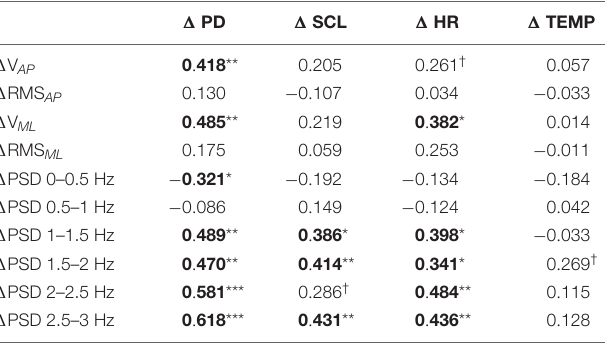
TABLE 5 | Correlation coefficients (robust percentage-bend correlation analysis) between the changes in psychophysiological and postural measures induced by exposure to virtual